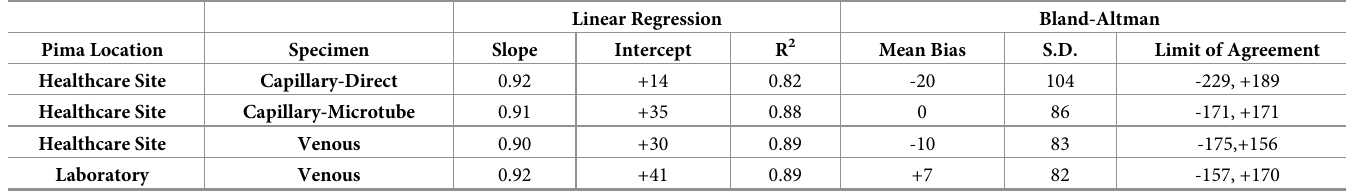
Table 6. Summary of scatterplot and Bland-Altman analysis of Pima CD4 testing compared to reference CD4 method per location and specimen